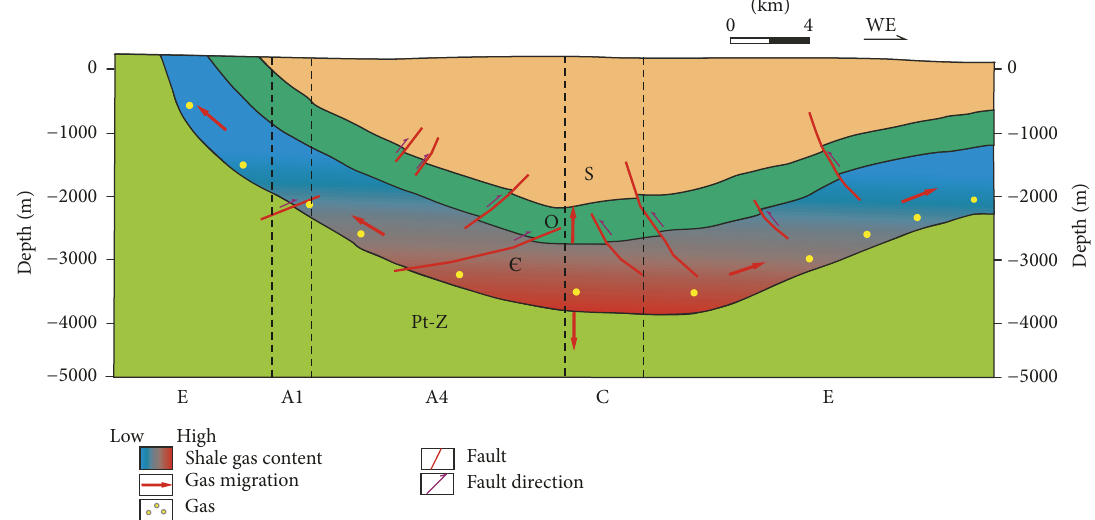
Figure 12: Evaluation units and shale gas accumulation diagram of seismic line EW308, Xiuwu Basin. See Figure 10 for the seismic